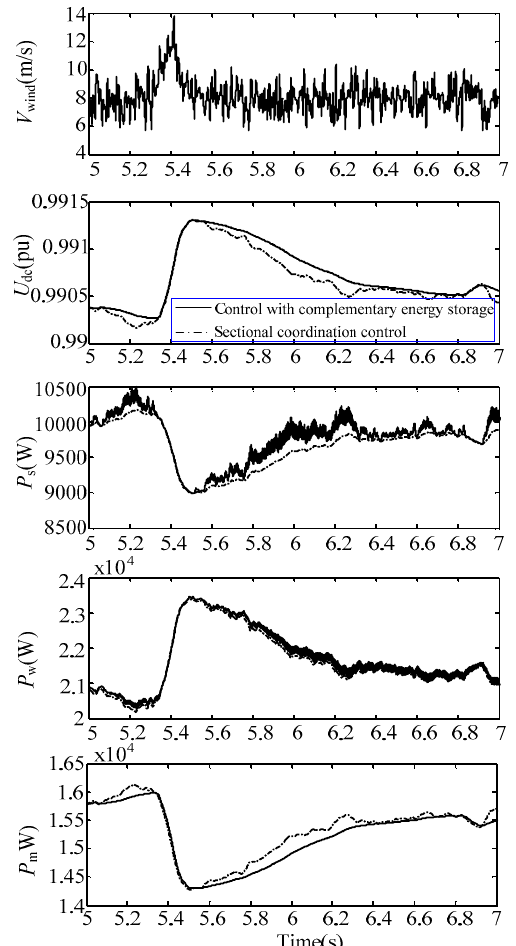
Figure 15. Performance of each unit in DC microgrid with simulated natural wind speed.